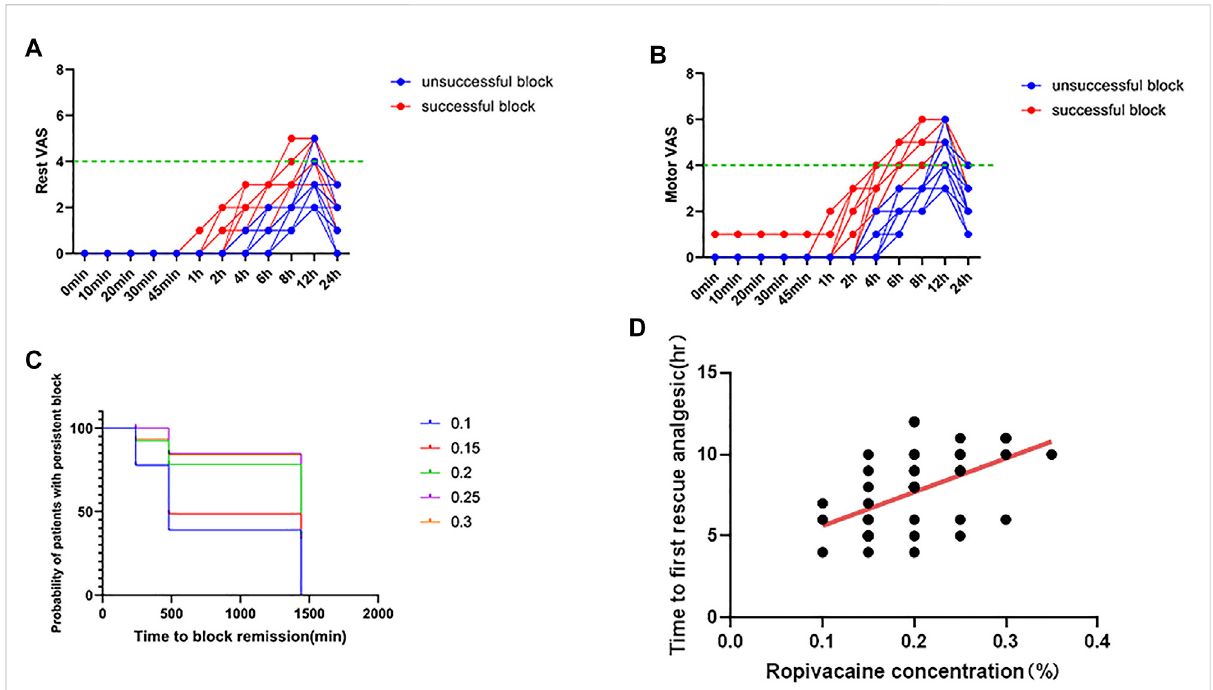
FIGURE 5 Postoperative pain scores. (A) Rest pain score 24 h after surgery. (B) Motor pain score 24 h after surgery. (C) Duration of the Interscalene Brachial Plexus Block with different concentrations of ropivacaine. (D) Correlation between ropivacaine concentration and time to fi rst rescue analgesia in interscalene brachial plexus